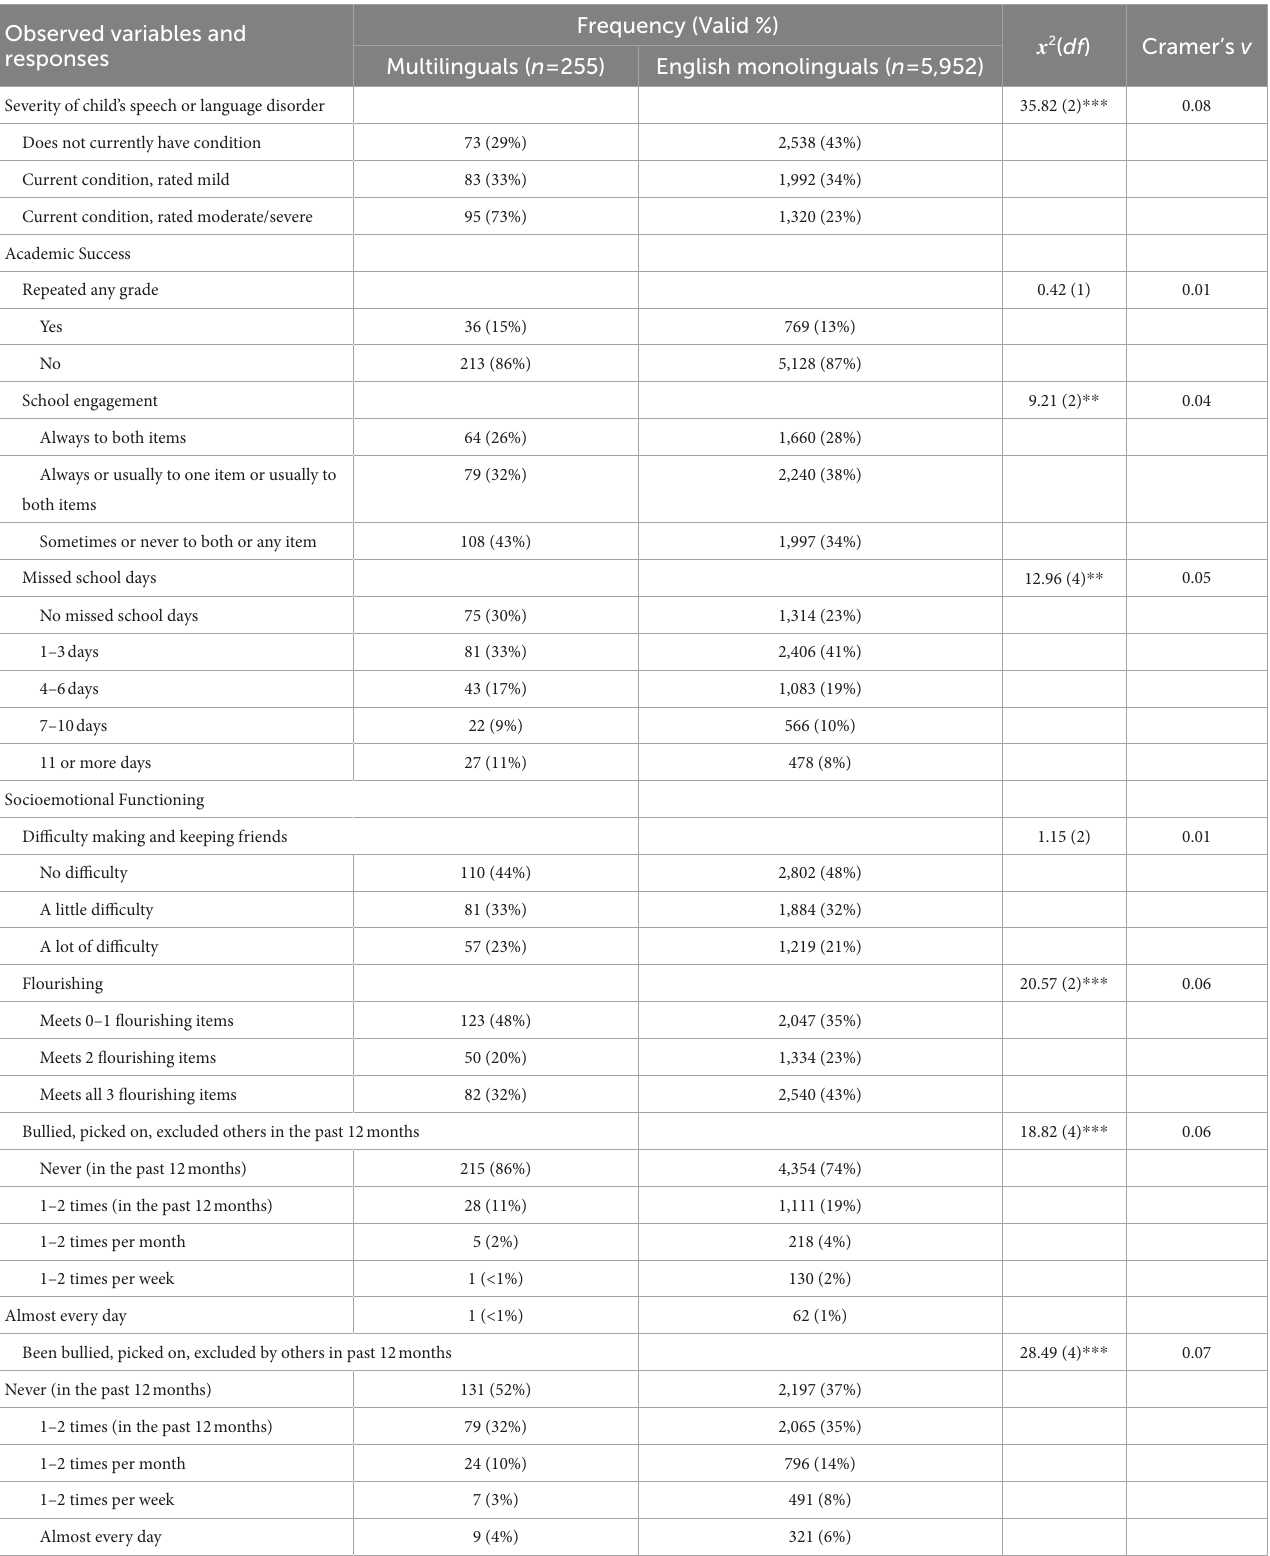
TABLE 2 Frequency distributions for the observed variables from the NSCH 2018–2020, n = 6,207. Observed variables and